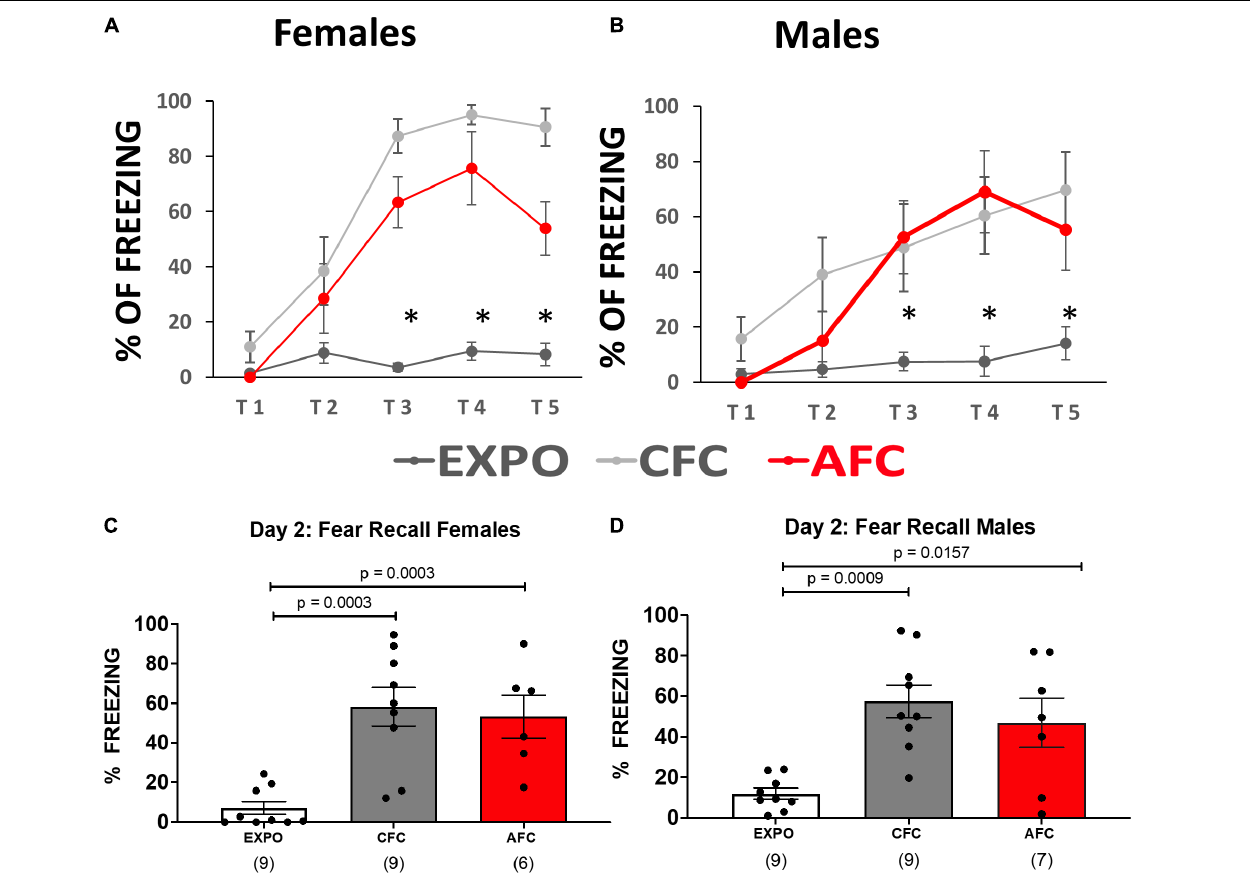
FIGURE 1 | Female and male rats acquired contextual and auditory fear. (A,B) Fear responses during training in the exposure, CFC, and AFC females and males, respectively. Asterisk denotes trials in which the CFC and AFC groups show more freezing than the exposure group ( p ≤ 0.05). (C,D) Long-term memory on day 2 of female and male groups showing freezing to the context in the EXPO and CFC groups and to the tone in the AFC group. Sample sizes are indicated below each bar in parentheses.